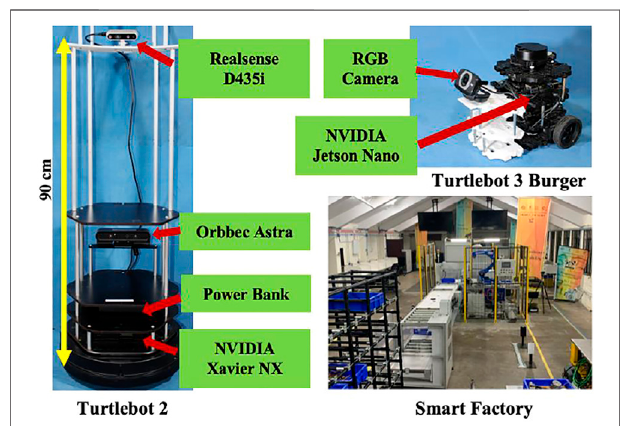
FIGURE 7 | Experimental test